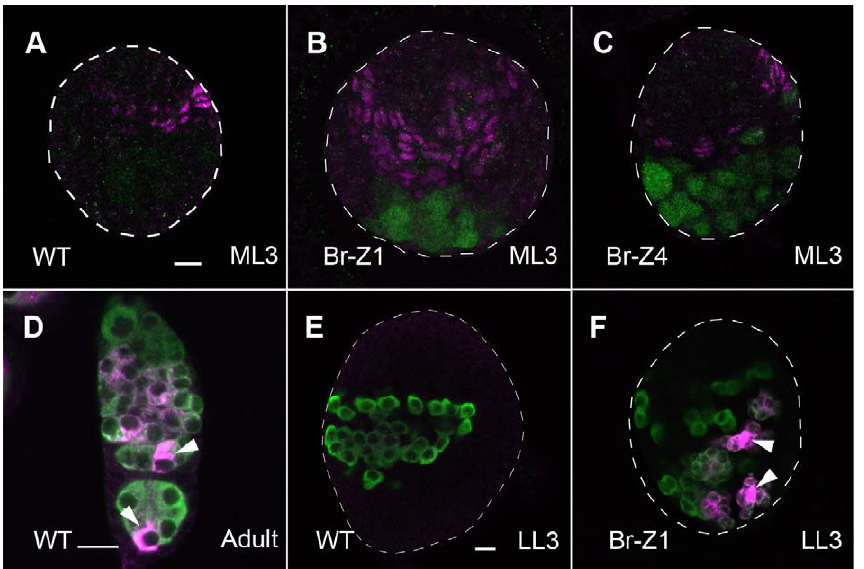
Figure 5. Broad over-expression results in precocious niche and PGC differentiation. (A–C) TF cells are marked by anti-Engrailed (magenta). Differentiating PGCs are marked by bamP -GFP (anti-GFP, green). (A) In wild type ML3 ovaries, TF formation initiates, but PGCs are not yet differentiating. No GFP labeling is evident. (B, C) In Br-Z1 (B) and Br-Z4 (C) over-expressing ML3 ovaries, substantial PGC differentiation is observed. More TF cells are specified in Br-Z1, but not in Br-Z4 ovaries. (D–F) PGCs are labeled green (anti-Vasa). (D) In a wild-type adult germarium, 8- and 16- cell cysts are labeled with anti-Orb (magenta). Orb localizes to the selected oocyte (arrowheads). (E) Wild-type PGCs do not express Orb. (F) Cysts in Br-Z1 over-expressing ovaries can express Orb, which is sometimes localized to an oocyte (arrowheads). Bars in (A) (for A–C), in (D), and in (E) (for E, F) are 10 m m.